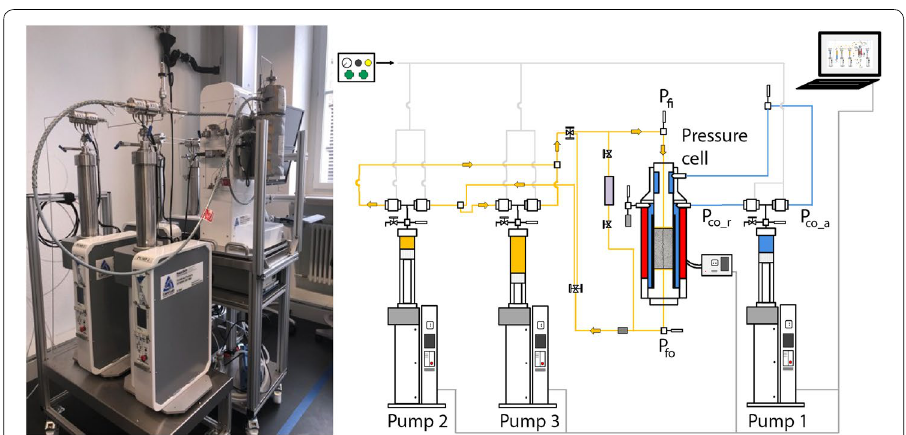
Fig. 4 Experimental setup. The injection of deionized water through the fractured granodiorite cores is carried out by Pump 2 at a constant fluid flow rate. The effluent fluid enters Pump 3 at a constant outlet pore‑fluid pressure, P fo . Pump 1 sets the axial and radial confining pressures, respectively, P co_a and P